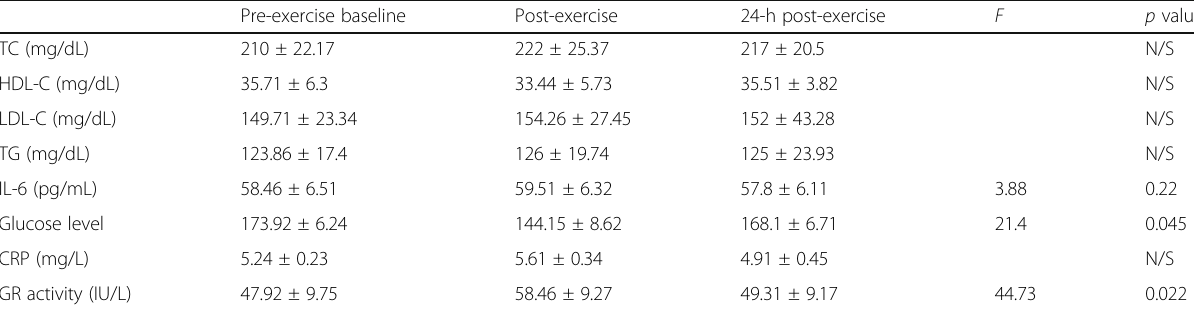
Table 6 Laboratory parameters before and after exercise Pre-exercise baseline